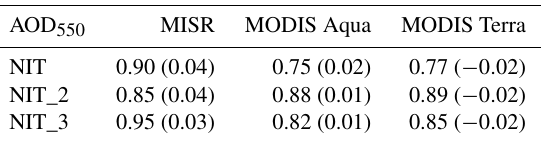
Table 6. Temporal correlation (and bias), over Europe, between mean annual cycles as plotted in Fig. 6 from simulations (NIT, NIT_2 and NIT_3) and satellite products (MISR, MODIS Aqua and MODIS Terra) over the period 2001–2016 (2003–2016 for MODIS